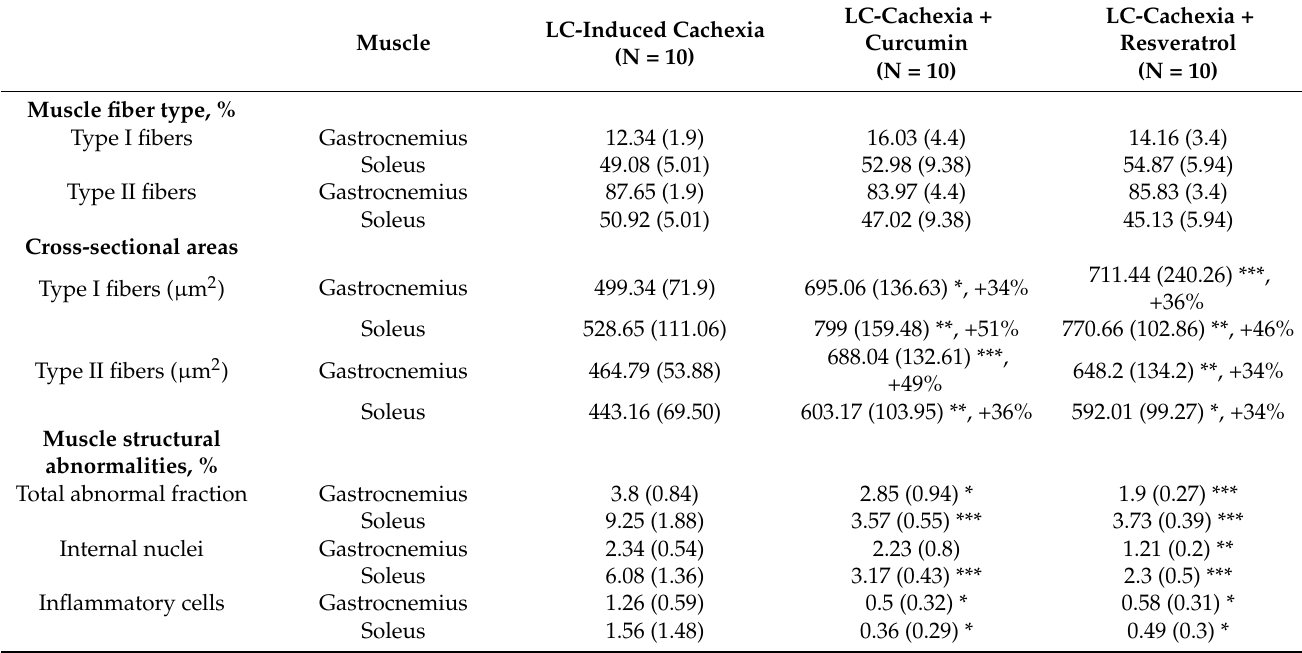
Table 2. Structural characteristics of the gastrocnemius and soleus muscles in the study groups of